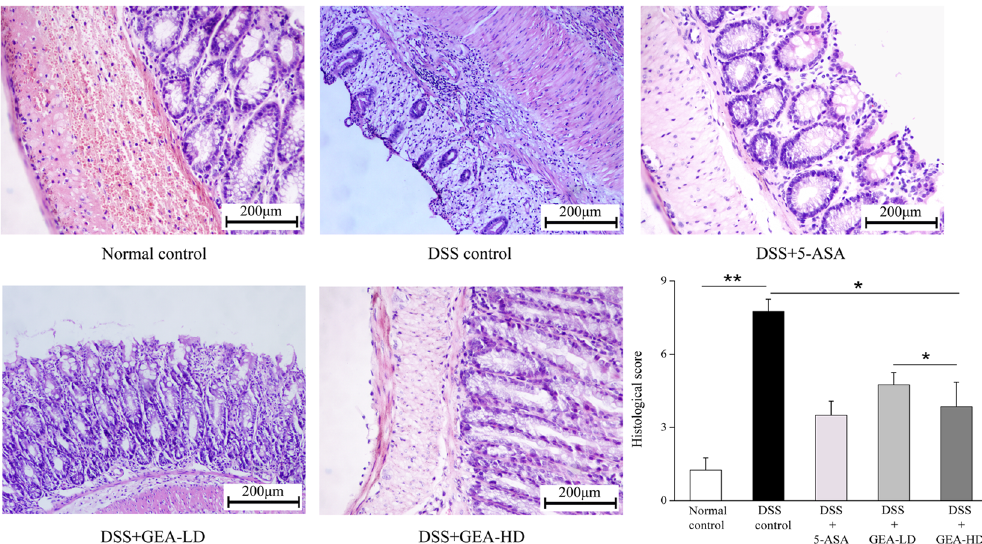
Figure 9. Turkish galls histologically inhibits DSS-induced UC in KM mice. The distal colon was stained by H&E-stained. Microscopic analysis shows that smaller and fewer colonic ulcers were detected in the GEA-LD group. This protected colonic epithelial cells from being damaged compared with the DSS control mice. The histological score was significantly lower in the Turkish galls group compared to the DSS group (P < 0.05). Scale bar = 200 μ m. The values are expressed as the mean ± S.D. * P < 0.05, ** P < 0.01, *** P < 0.001.